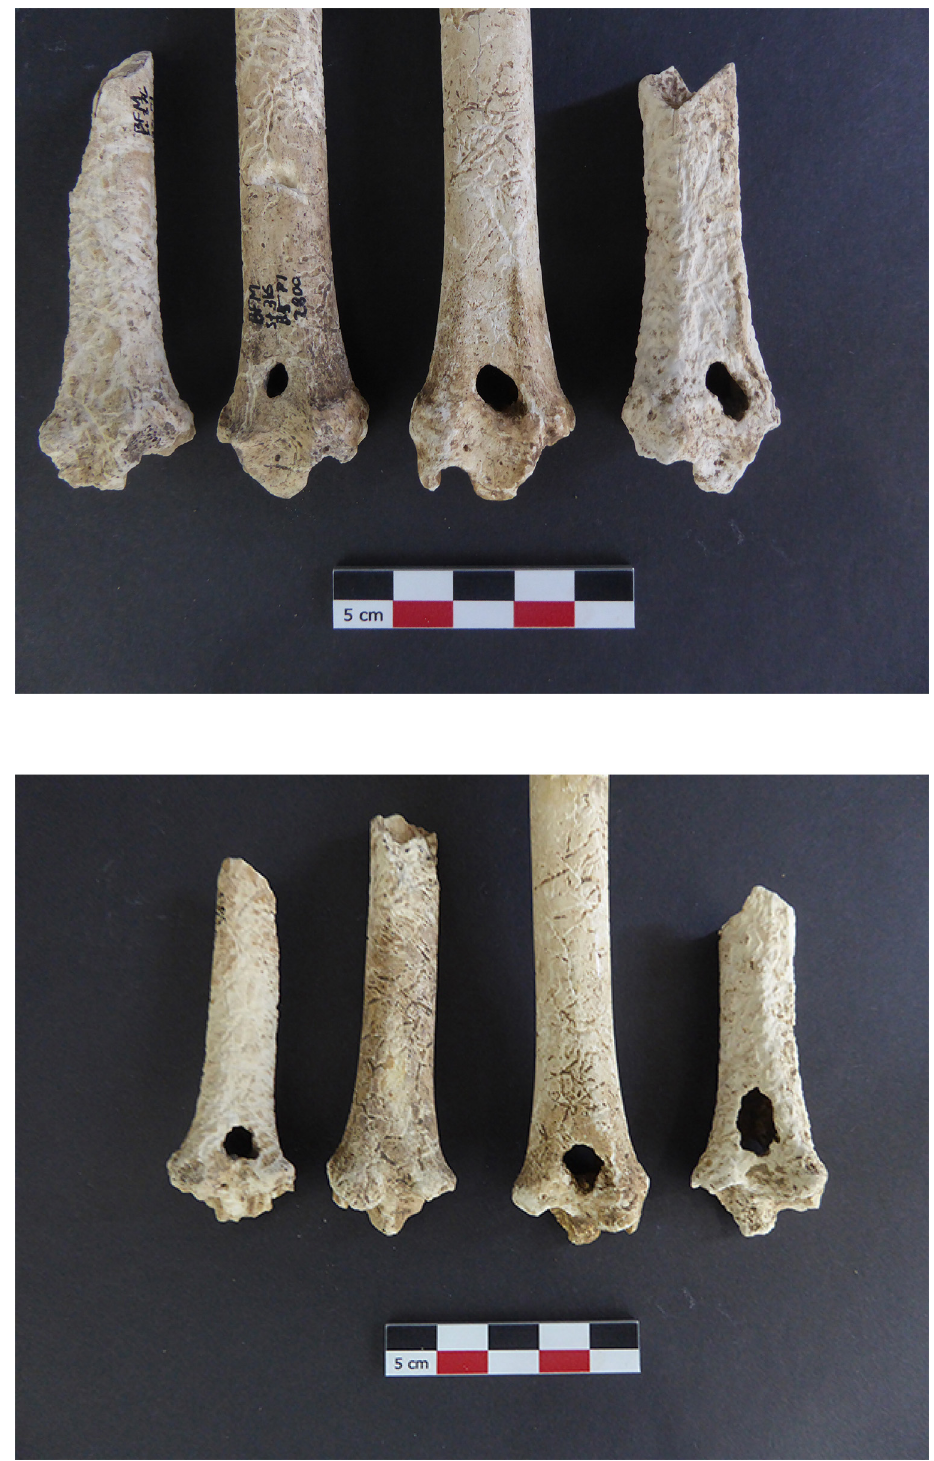
Figure 8: Example of perforated tibias, distal part. Top: anterior, bottom: posterior. Photos L.